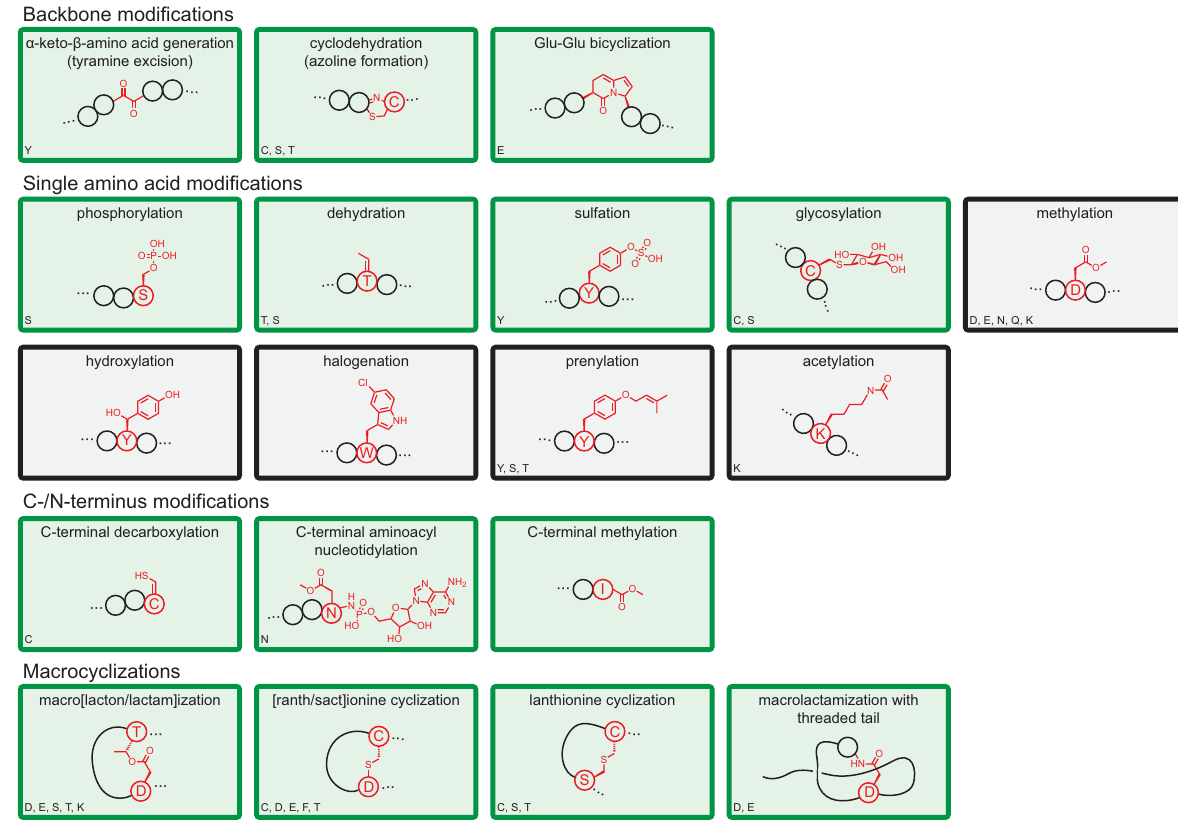
Fig 5. Summary of RiPP chemical modifications. All enzyme modification chemistries used in this publication. Example structures are shown in each box, with the modified residues/structures highlighted in red. Amino acids involved are listed in the lower left of each box (if amino acids are chemically restrictive). Green boxes are those for which we observed functional enzymes in our expression system. Black boxes were tested, but no tested enzymes were functional.